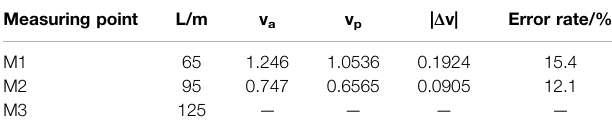
TABLE 2 | Comparison of simulated and measured group-hole blasting vibration data.